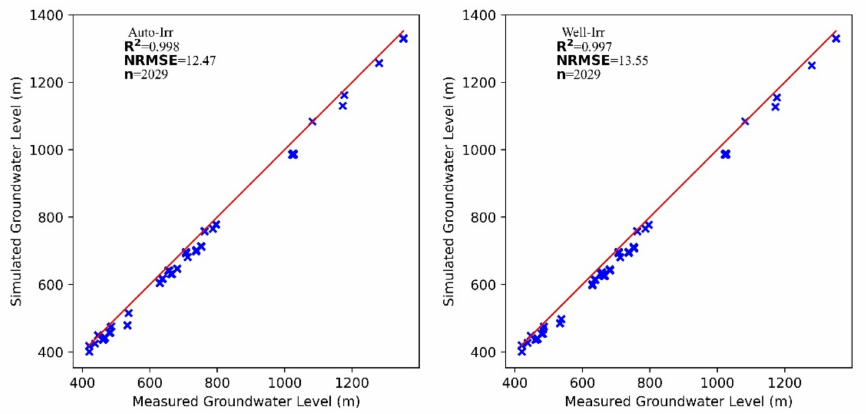
Figure 4. Comparison of observed and simulated mean monthly groundwater level of Auto-Irr and Well-Irr for the period of 1982–2008.